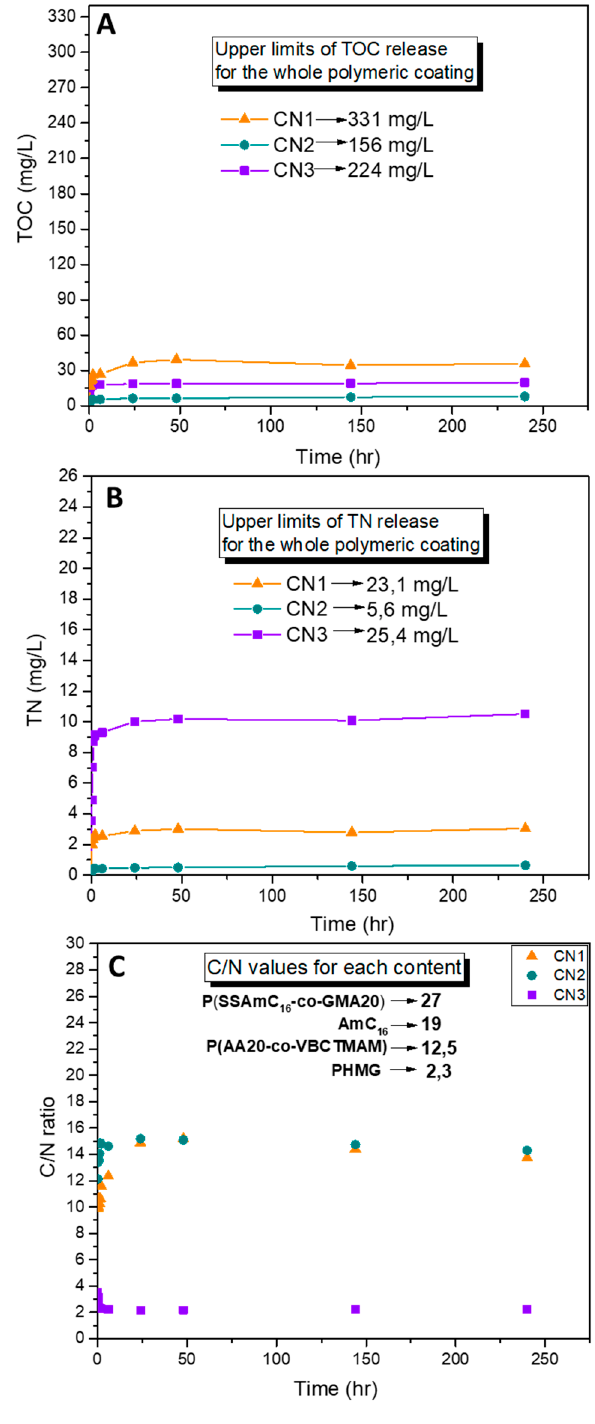
Figure 5. Measurements of ( A ) Total Organic Carbon (TOC), ( B ) Total Nitrogen (TN) and ( C ) atomic C/N r ratio as a function of time after immersion of coated nets CN1, CN2 and CN3 in 0.6 M NaCl solution for 10 days (1st cycle).